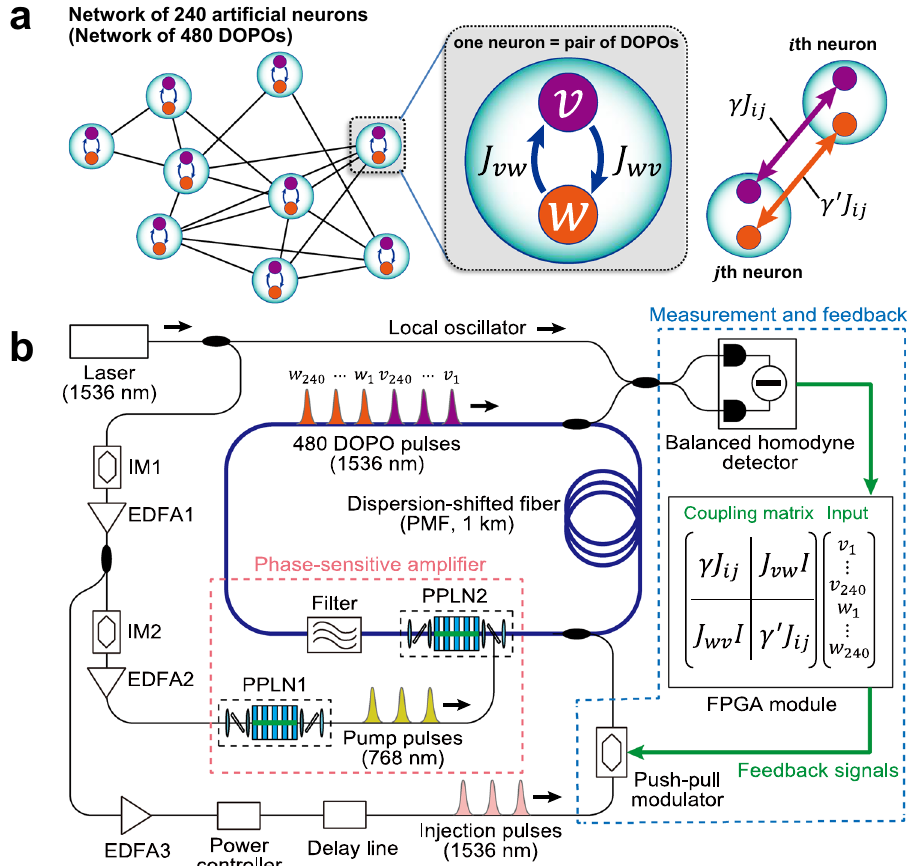
Fig. 1 Experimental setup of a DOPO neural network. a 240-node arti fi cial neural network composed of 480 DOPOs with antisymmetric couplings ( J vw ¼ (cid:2) J wv ). b Schematic diagram based on time-domain multiplexing in a 1-km fi ber-ring cavity. PPLN, periodically poled lithium-niobate; PMF, polarization-maintaining fi ber; IM, intensity modulator; EDFA, erbium-doped- fi ber ampli fi er; FPGA, fi eld-programmable gate